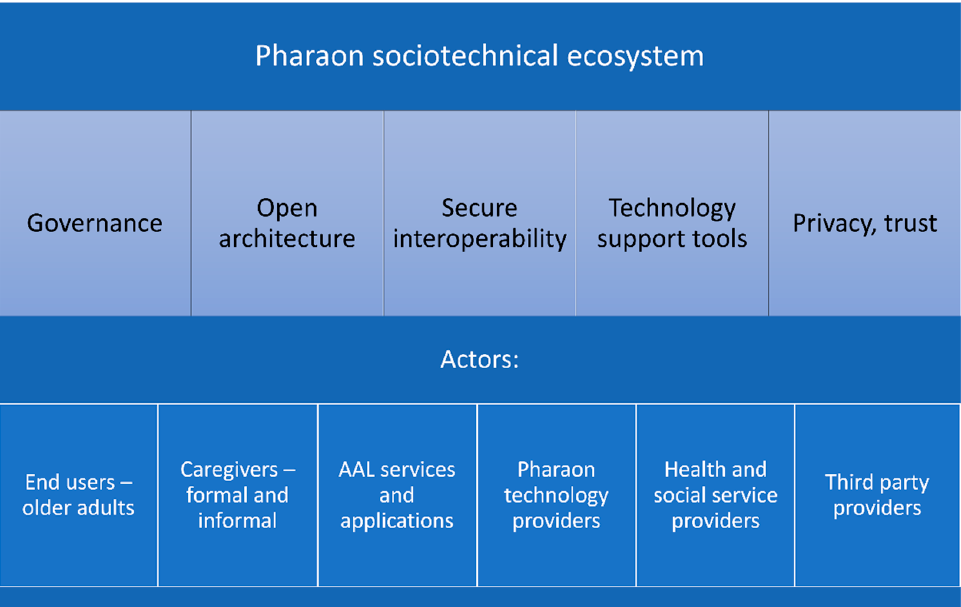
Figure 8. Pharaon ecosystem